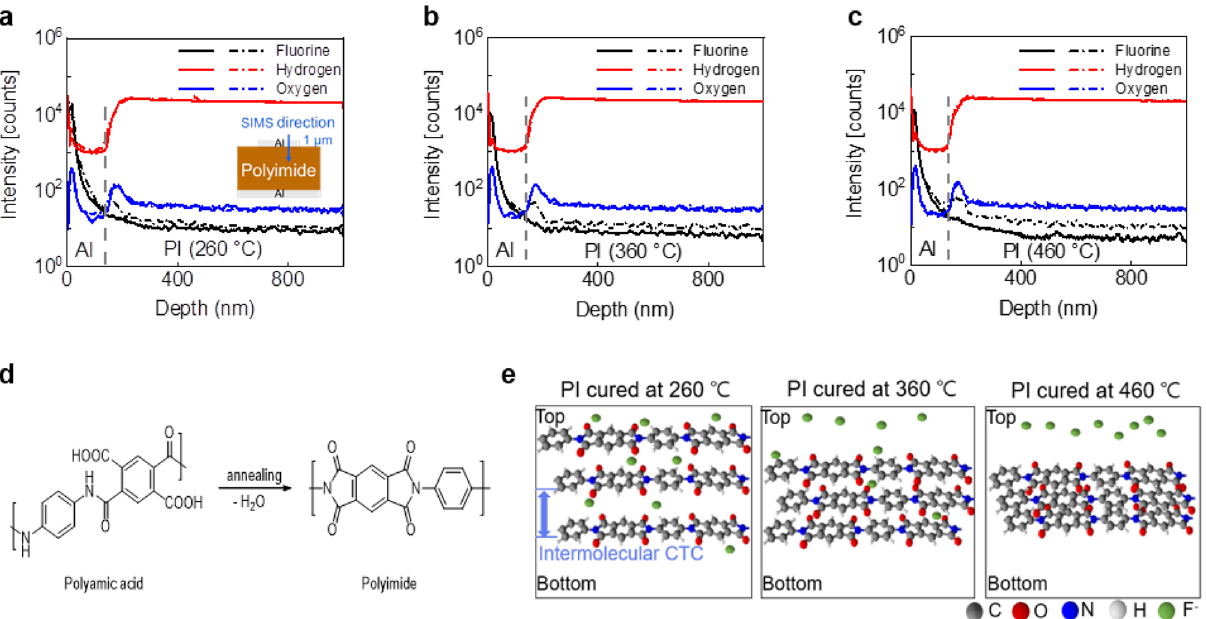
Figure 3. SIMS analysis and PI structure. ( a – c ) SIMS analysis of MIM capacitors before (dashed line) and after (dash dotted line) NBTS. ( d ) Chemical structure of PI. ( e ) Geometry of polyimide by curing